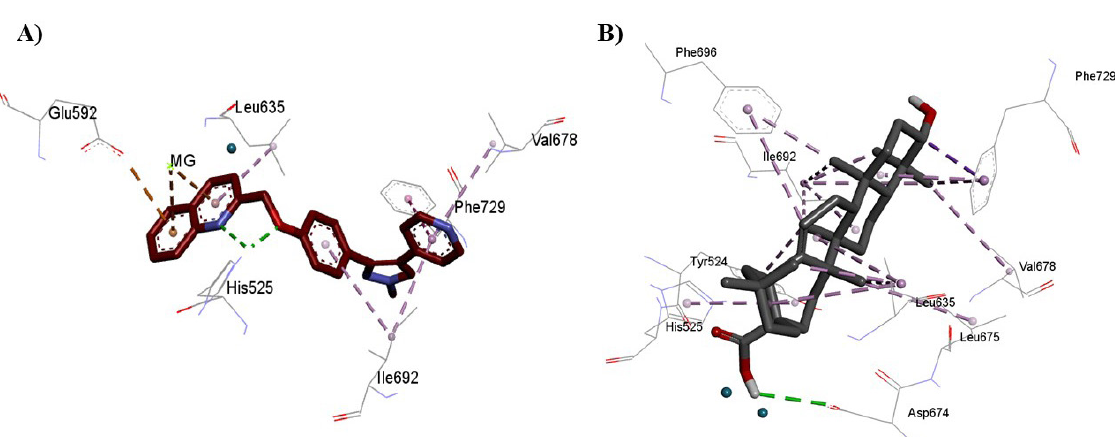
FIGURE 6 - The binding interactions between the ligands and PDE10A receptor. A) MP-10 B) Oleanic acid. Hydrogen bonds are presented by green, Pi-alkyl by pink, Pi-cation/anion by orange, Pi-sigma by violet and Pi-Pi stacking interactions by magenta dotted lines.